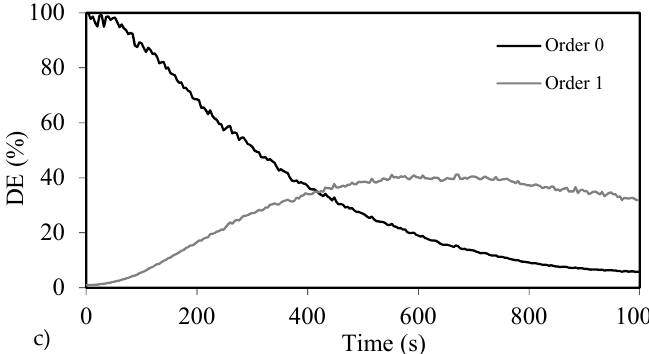
Figure 10. Diffraction efficiency of zero and first orders as a function of time for 720 µm ( a ), 336 µm ( b ) and 168 µm ( c ) blazed gratings recorded onto NPC material.